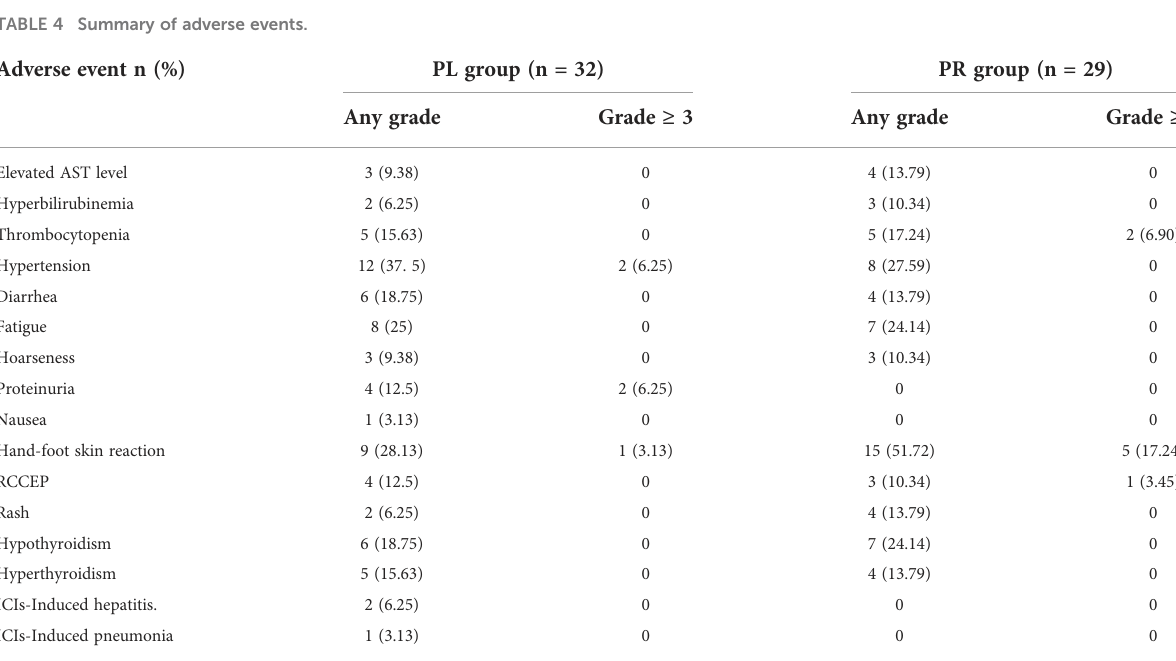
TABLE 4 Summary of adverse